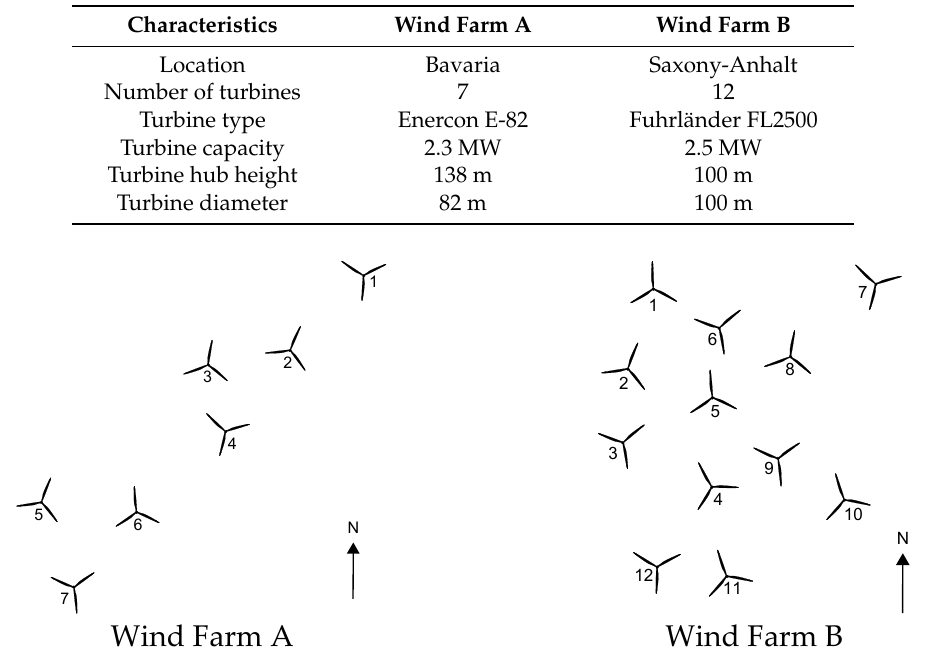
Figure 3. Turbine configuration of wind farm A ( left ) and B ( right ).